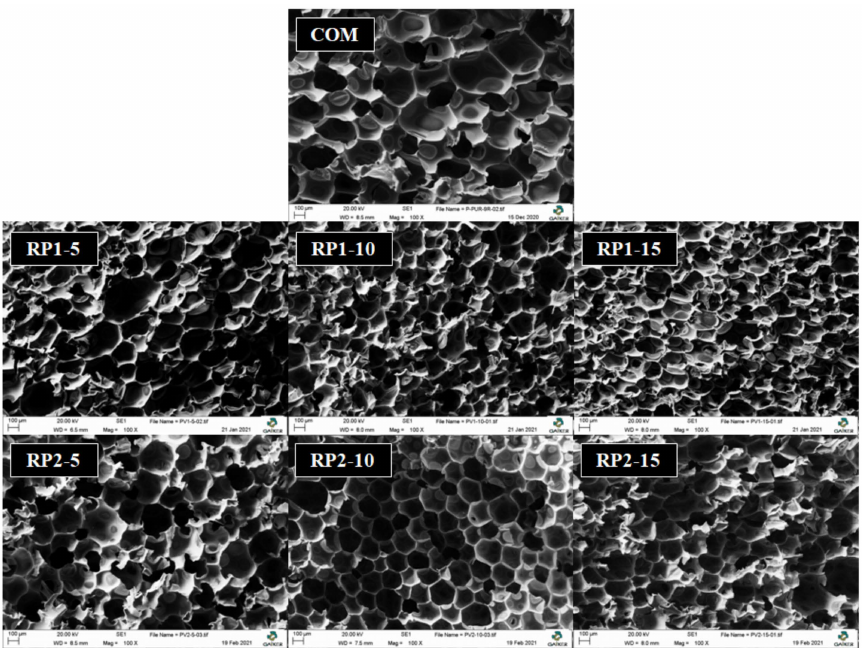
Figure 8. SEM images of cross sections of RPUFs with different RP contents.